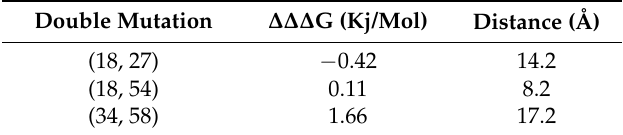
Table 5. The free energy changes of 13 double mutations in T4 phage lysozyme by MAESTROweb. Double Mutation ∆∆∆ G (Kj/Mol) Distance